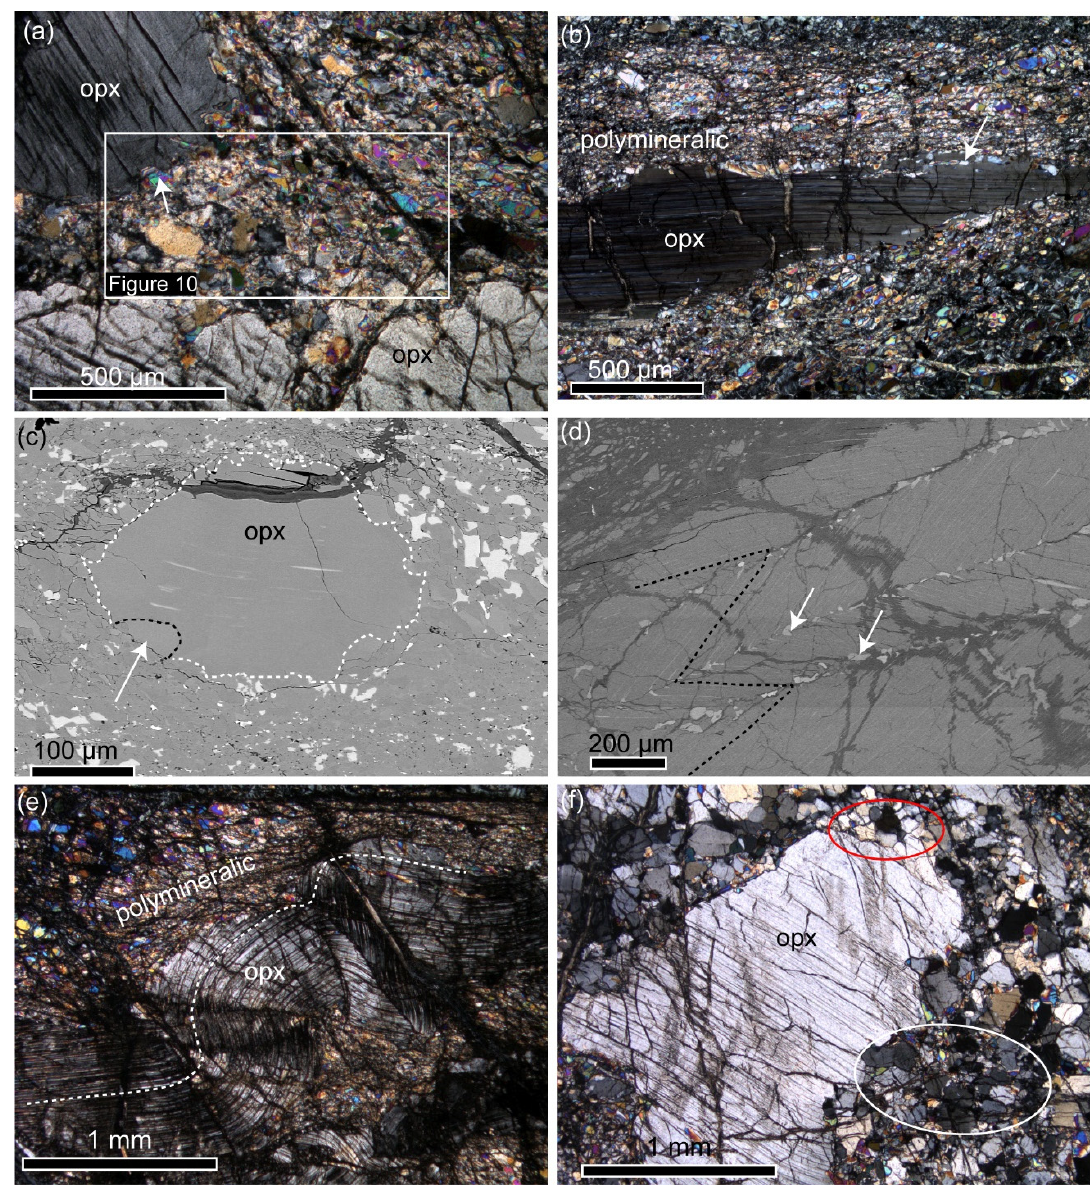
Figure 4. Orthopyroxene porphyroclasts. ( a ) Optical microscope image under crossed polarized light of an orthopyroxene porphyroclast with olivine embayments (arrow). Indicated is the location of the EBSD map of Figure 10. ( b ) Optical microscope image under crossed polarized light of an elongated opx porphyroclasts surrounded by fine-grained polymineralic layers. The porphyroclast shows embayments of olivine (arrow). ( c ) BSE image of an opx porphyroclast (dashed white line) showing cpx exsolution lamellae and olivine embayment (arrow). The porphyroclast is located in a fine-grained polymineralic (opx + ol + cpx + spinel) matrix. ( d ) BSE image of a kinked opx porphyroclast (black dashed line traces a cpx exsolution lamellae) with small cpx (white arrows) on the kinks and grains at the border. ( e ) Folded opx porphyroclasts with cpx exsolution lamellae and a fine-grained polymineralic rim. ( f ) Orthopyroxene porphyroclast surrounded by relatively coarse grains of opx (compared to ( e )). Some opx grains show close to 120° interfacial angles at triple junctions (red circle). The area in the white circle includes, besides opx, smaller grains of olivine, cpx and spinel.